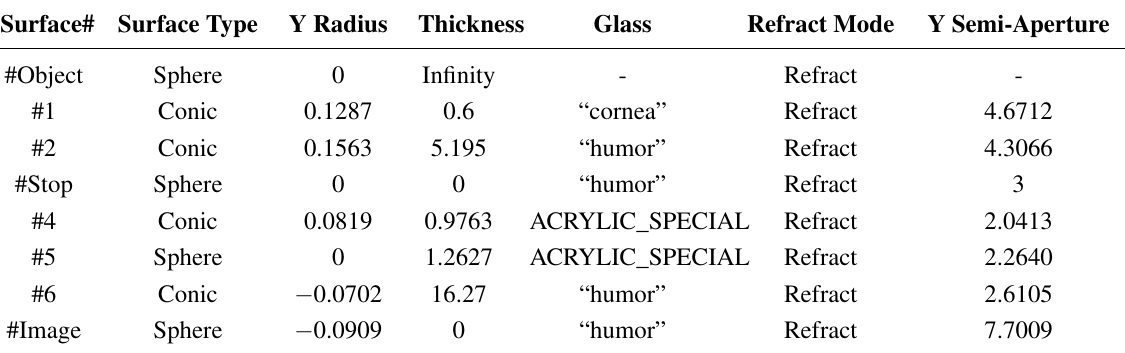
Table 6. The lens parameter after CODE V optimization for pupil size 6 mm.